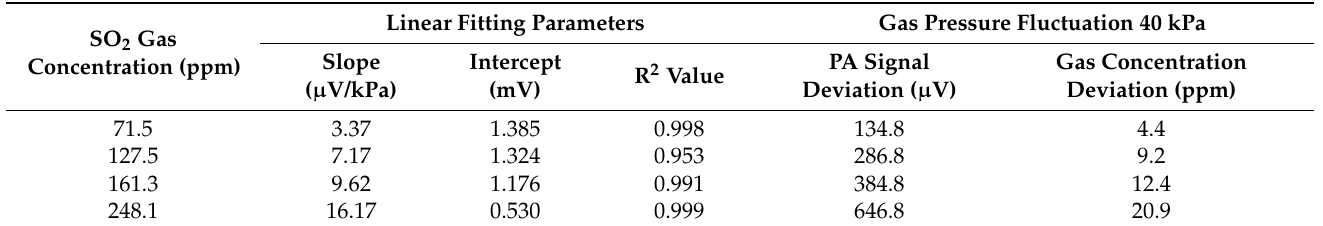
Table 3. Linear fitting parameters and measured deviation induced by pressure fluctuation.